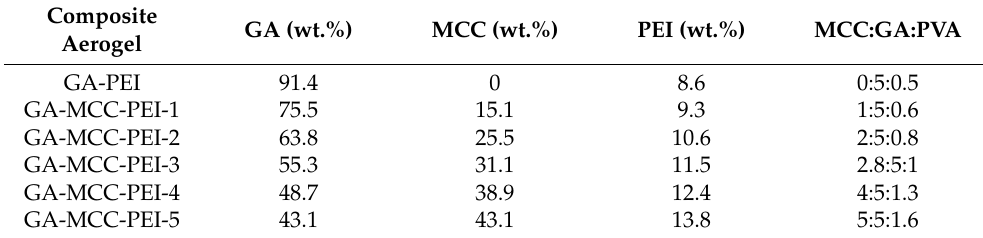
Table 1. Content of each component in composite